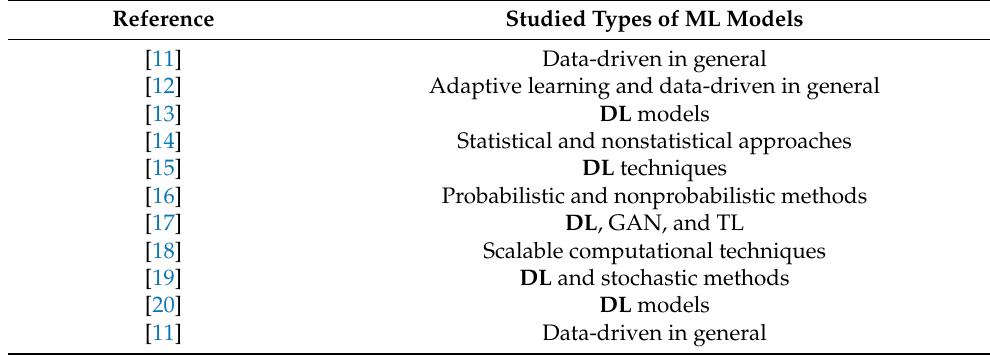
Table 1. Most studied types of ML models in the